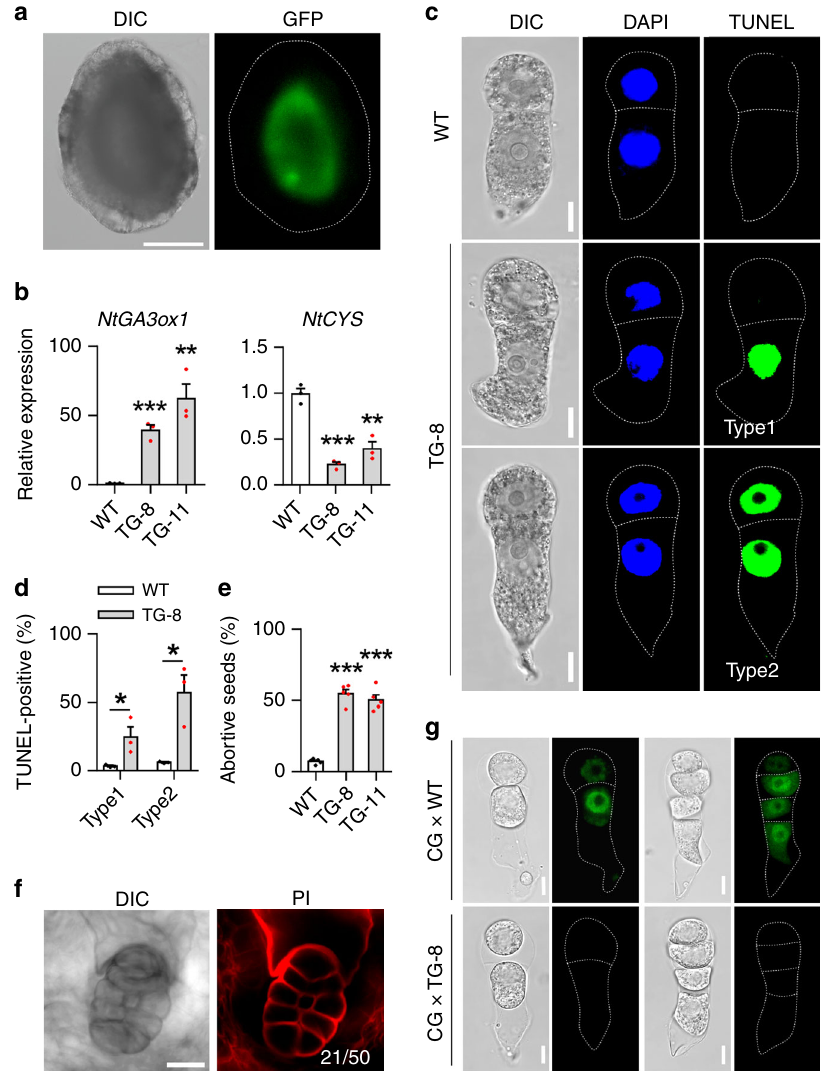
Fig. 6 Ectopic expression of NtGA3ox1-GFP in the endothelium triggers PCD. a Localization of NtGA3ox1-GFP in the endothelium of pNtTPE8::NtGA3ox1-GFP plant. b Increased expression of NtGA3ox1 and decreased expression of NtCYS in the TG-8 and TG-11 lines. c TUNEL test in two-celled proembryos from WT and TG-8. d Frequency of two-celled proembryos with TUNEL-positive apical and basal cells in WT and TG-8 ( n = 105 – 112). e Frequency of aborted seeds in WT and TG-8. ( n = 1000 – 1500). f PI-staining of abnormal embryos with no suspensor in the TG-8 line. g NtCRF1-GFP signal in early proembryos after crossing WT and pNtCRF1::NtCRF1-GFP (CG) lines. Data are the means ± SE of 3 independent experiments in ( b , c ) and 5 in e (Student ’ s t -test, * P < 0.05, ** P < 0.01, *** P < 0.001); Scale bars: 150 μ m ( a ), 10 μ m ( c , g ), 20 μ m ( f ). The source data of the graphs are provided in the Source Data fi